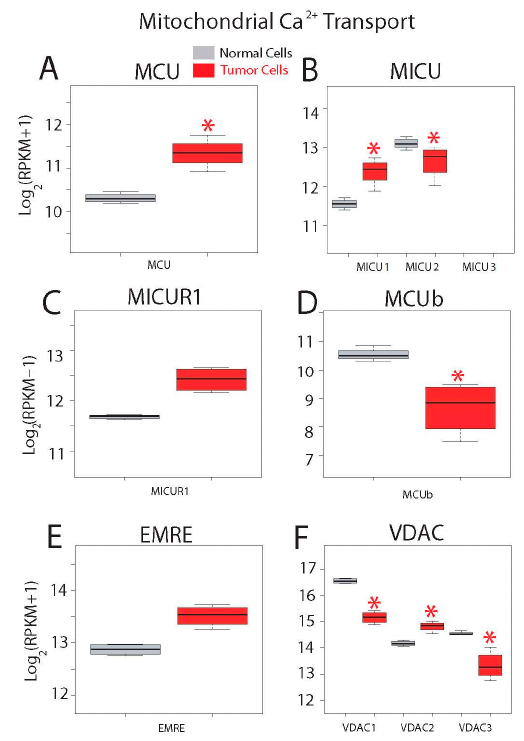
Figure 13. Expression of genes involved in mitochondrial Ca 2+ transport in normal and colon cancer cells. Expression levels of Mitochondrial Calcium Uniporter (MCU) ( A ), Mitochondrial Calcium Uptake (MICU) isoforms ( B ), Mitochondrial Calcium Uptake Regulator 1 (MICUR1) ( C ), Mitochondrial Calcium Uniporter Dominant Negative Beta Subunit (MCUb) ( D ), Essential MCU regulator (EMRE) ( E ) and voltage-dependent anion channels (VDACs) ( F ) in normal colonic cells (grey bars) and colon cancer cells (red bars). * p statistically significant by three independent methods.